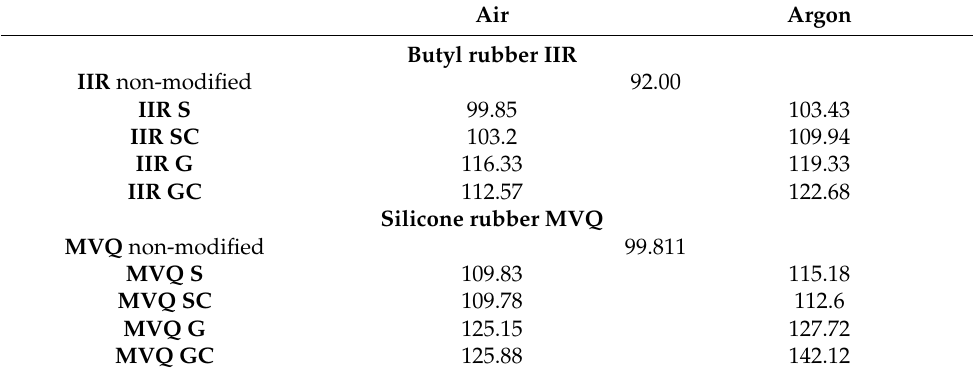
Table 3. Summary of the analysed materials’ contact angle values.